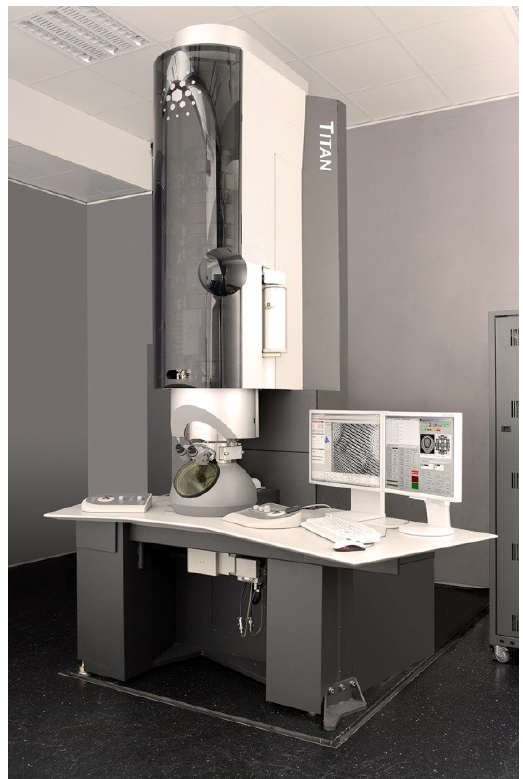
Figure 1: FEI Titan 80-300 transmission electron microscope (photograph by courtesy of Ralf-Uwe Limbach (Forschungszentrum